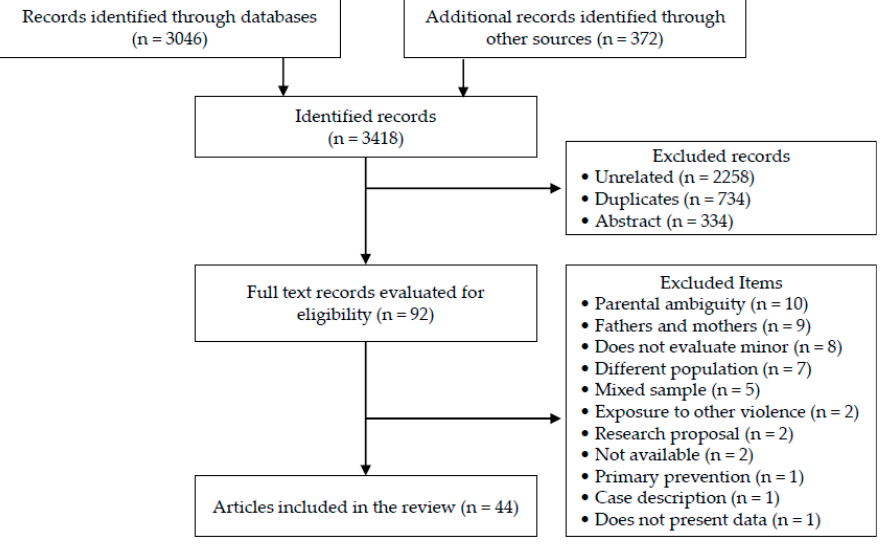
Figure 1. Flow diagram.